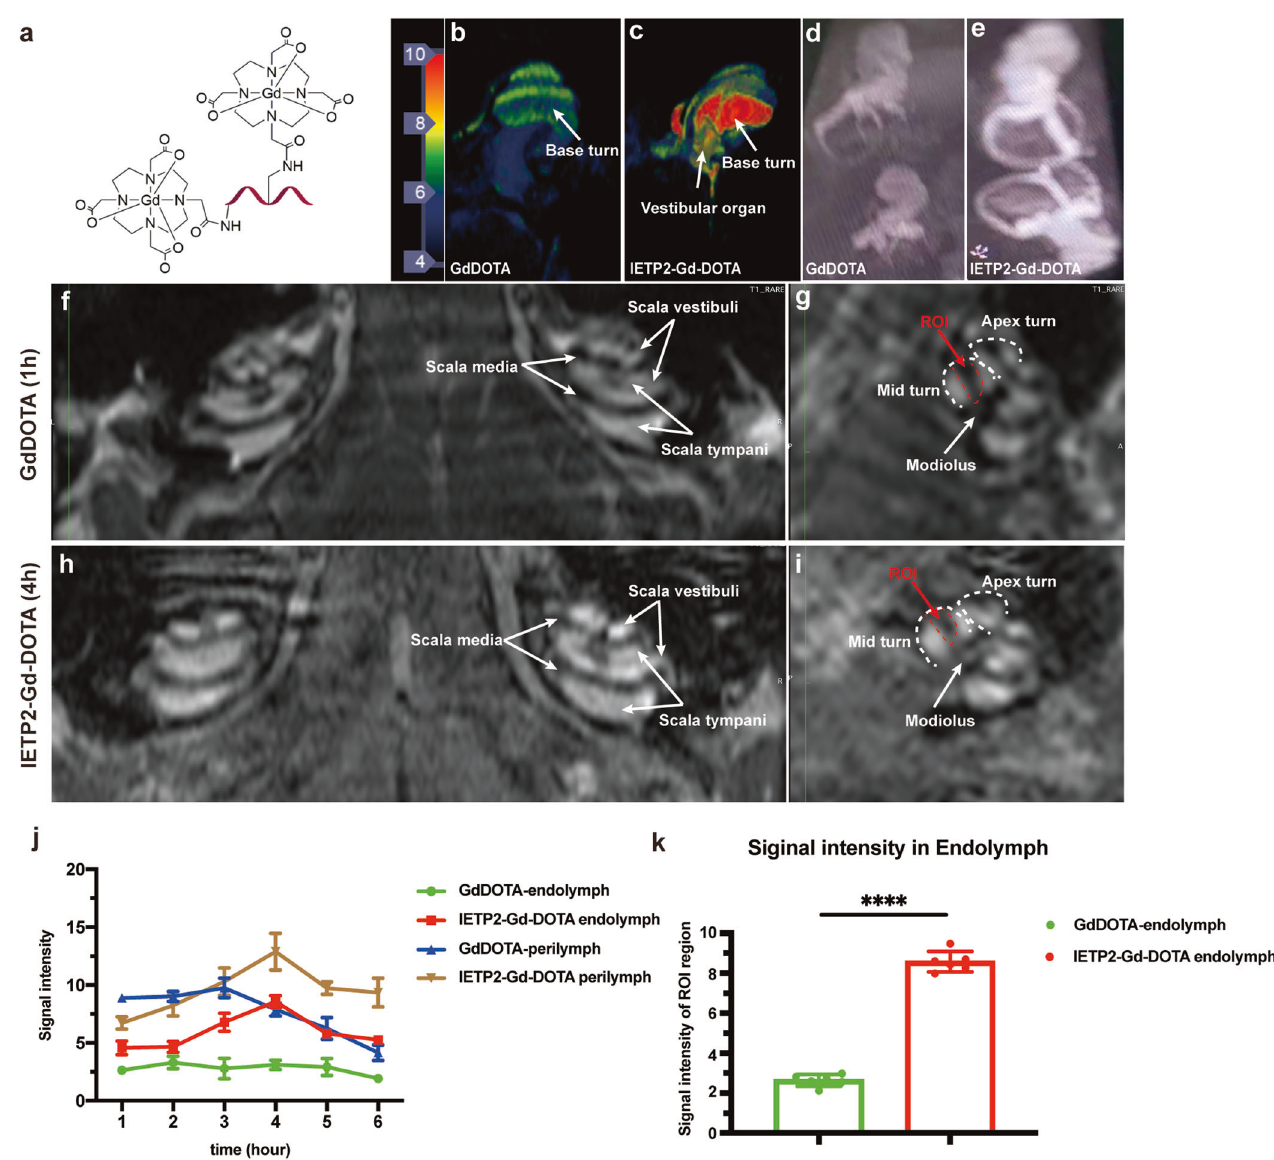
Fig. 5 IETP2 delivers MRI contrast agent across the BLB. a Schematic representation of the structure of IETP2-Gd-DOTA. Two GdDOTA molecules were attached to one peptide molecule. The red ribbon represents IETP2. b , c 7.0 T MRI images of isolated cochleae from mice injected with IETP2-Gd-DOTA or free Gd-DOTA at 5 min after injection. Dosage: 1.5 mmol gadolinium/kg. The color bar on the left shows the MRI signal intensity; red indicates high signal intensity, while blue indicates low signal intensity. d , e 7.0 T MRI images of isolated cochleae of mice injected with IETP2-Gd-DOTA or free GdDOTA at 2 h after injection. Dosage: 1.5 mmol gadolinium/kg. f , g In vivo cochlear MRI images ( f coronal plane; g para-sagittal plane) of mice injected with free GdDOTA at 1 h after intravenous injection. Dosage: 1.5 mmol gadolinium/kg. f The scala tympani and scala vestibuli were clearly enhanced, while the scala media remained at low intensity without enhancement. g Cross modiolus plane image of cochleae. An apex turn and midturn were seen (white dotted region). The ROI was the scala media region (red dotted region). h , i In vivo cochlear MRI image ( h coronal plane; i para-sagittal plane) of mice injected with IETP2-Gd-DOTA at 4 h after intravenous injection. Dosage: 1.5 mmol gadolinium/kg. h Scala tympani and scala vestibuli were clearly enhanced, and scala media were also enhanced. i Cross modiolus plane image of cochleae. An apex turn and a midturn were observed (white dotted region). The ROI was the scala media region (red dotted region). Images captured at 1 or 4 h are displayed in f – i due to the saturated signal intensity at these time points. j Time-course signal intensity of the endolymph and perilymph in mice injected with IETP2-Gd-DOTA or GdDOTA. k Quantitative representation of the MRI signal intensity of the perilymphatic regions in ( g and i ) 4 h after drug injection. Error bars represent the mean ± SD. N = 6. **** p <